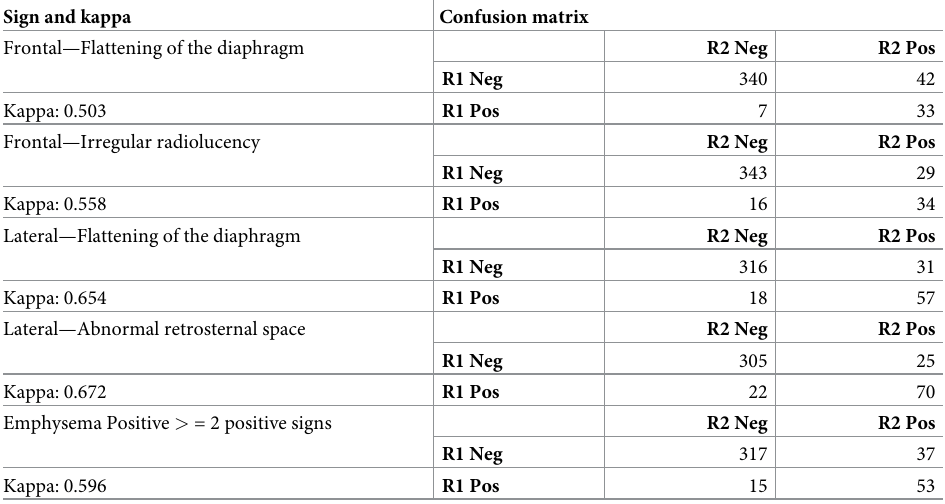
Table 4. Inter-observer variability. Sign and kappa Confusion matrix Frontal—Flattening of the diaphragm R2 Neg R2 Pos R1 Neg 340 42 Kappa: 0.503 R1 Pos 7 33 Frontal—Irregular radiolucency R2 Neg R2 Pos R1 Neg 343 29 Kappa: 0.558 R1 Pos 16 34 Lateral—Flattening of the diaphragm R2 Neg R2 Pos R1 Neg 316 31 Kappa: 0.654 R1 Pos 18 57 Lateral—Abnormal retrosternal space R2 Neg R2 Pos R1 Neg 305 25 Kappa: 0.672 R1 Pos 22 70 Emphysema Positive > = 2 positive signs R2 Neg R2 Pos R1 Neg 317 37 Kappa: 0.596 R1 Pos 15 53 Inter-observer variability and confusion matrices of the radiologist annotations for the 4 signs and the emphysema positive result ( � 2 positive signs) on 422